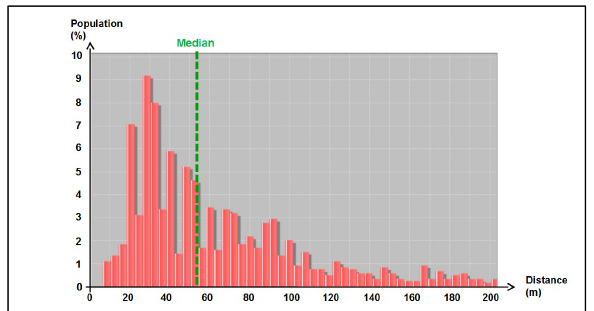
Figure 7. Inter-vertices distances of the road captured at the scale 1:25.000.